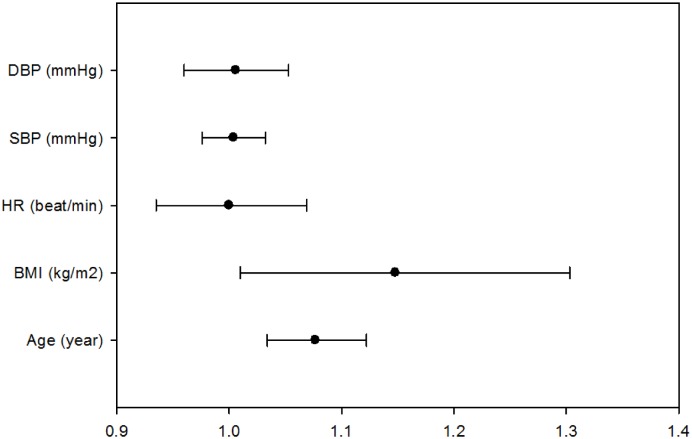
Odds ratio analysis for factors influencing the integrated scoring index.Age: 1.077 (CI: 1.034~1.122; p = 0.000); BMI: 1.148 (CI: 1.010~1.303; p = 0.034); HR: 1.000 (CI: 0.935~1.069; p = 0.998); SBP: 1.004 (CI: 0.976~ 1.032; p = 0.797); DBP: 1.006 (CI: 0.960~1.053; p = 0.807). BMI = body mass index, HR = heart rate, SBP = systolic blood pressure, DBP = diastolic blood pressure.